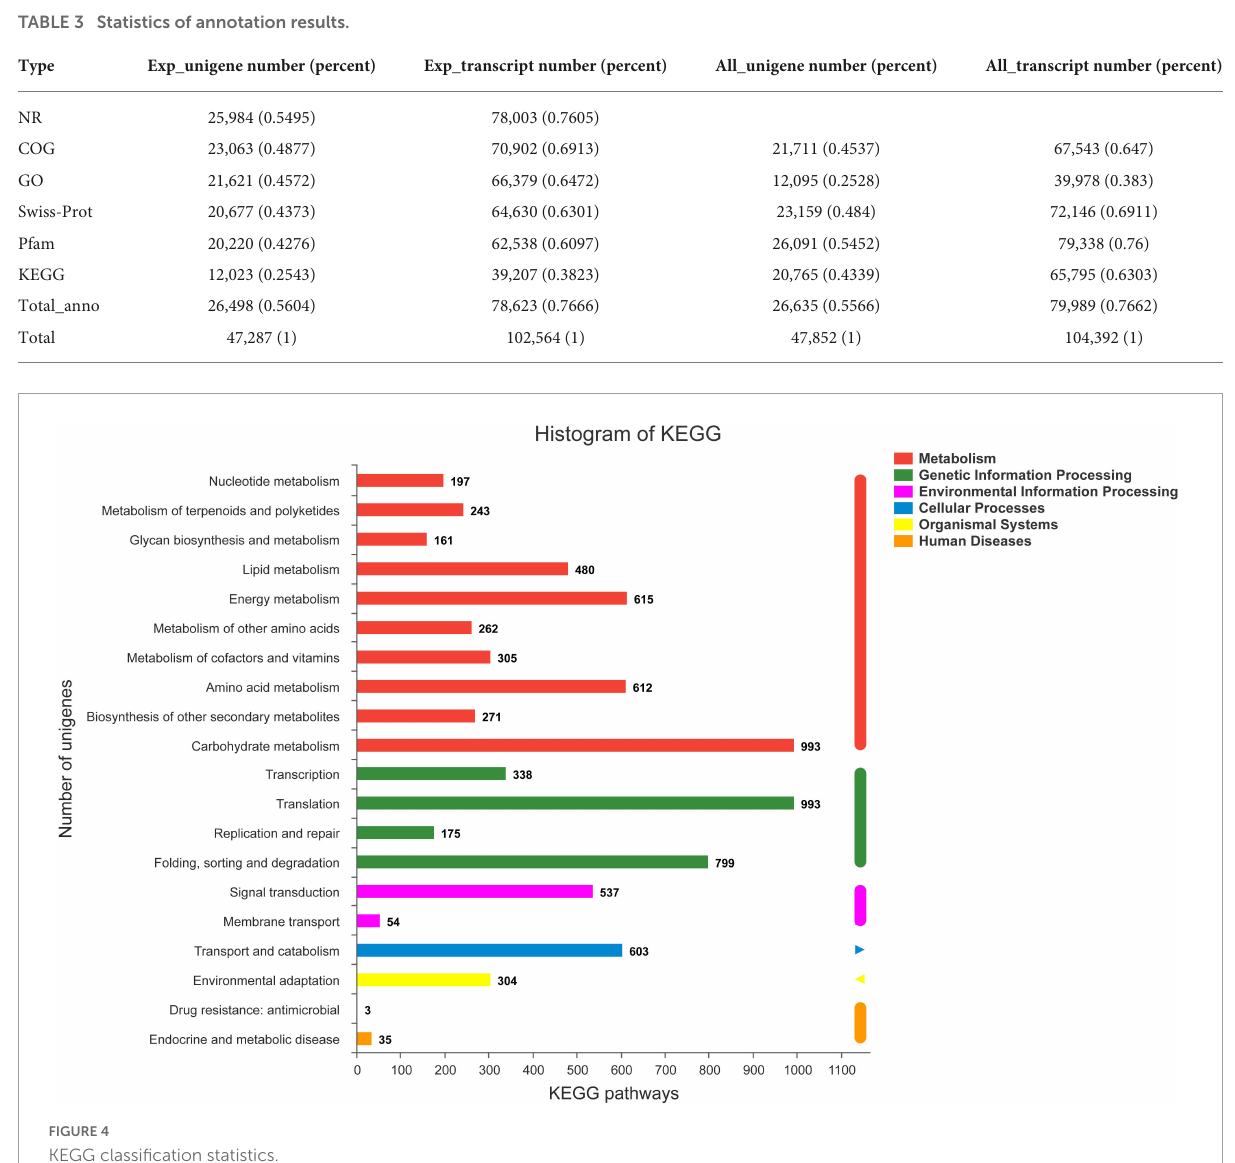
FIGURE4 KEGG classification